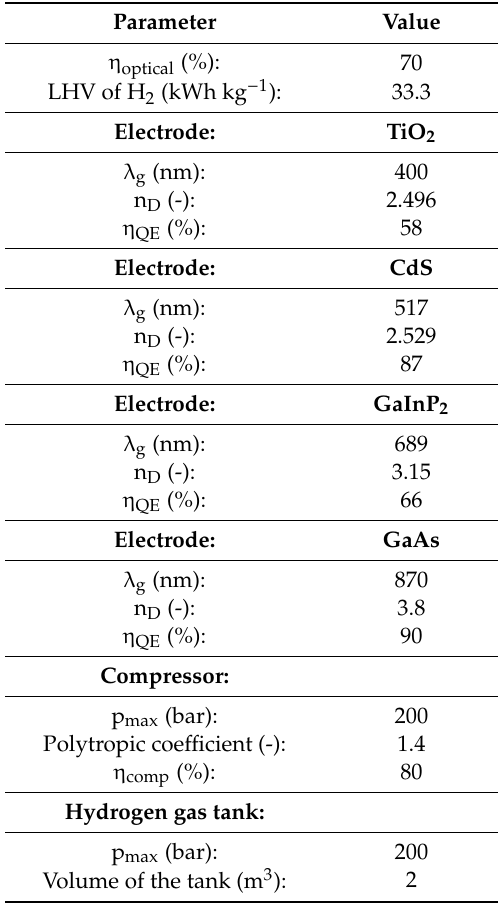
Table 2. Parameters and settings for the PEC group.